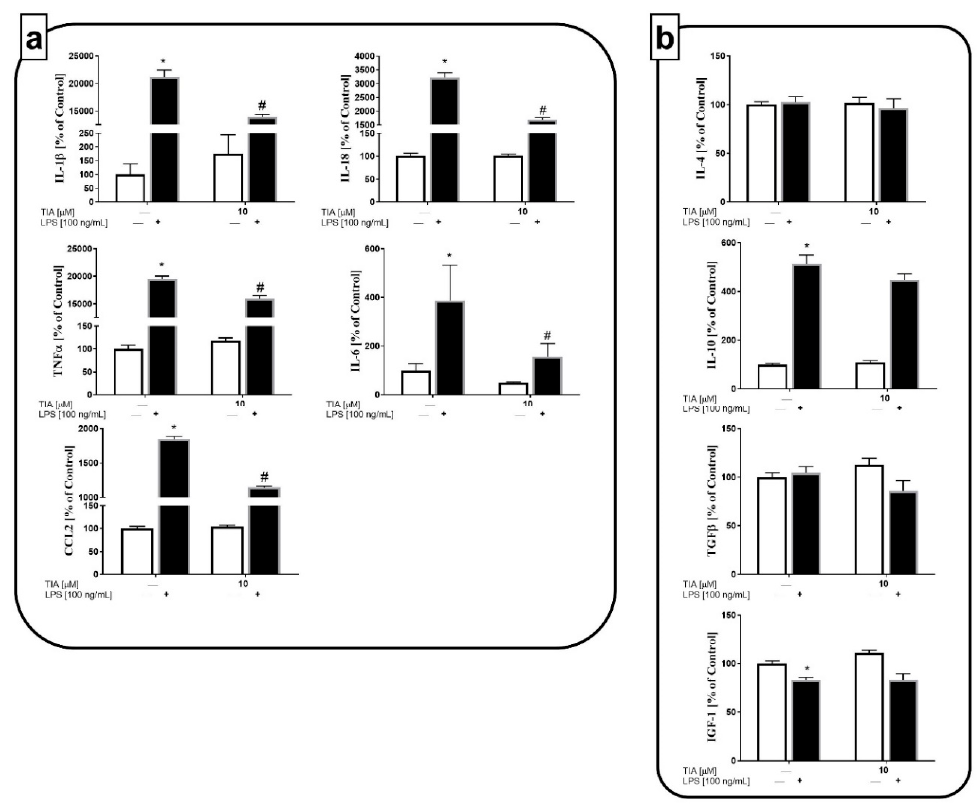
Figure 4. The effect of tianeptine (TIA) on the levels of pro-inflammatory (interleukin (IL)-1 β , IL-18, tumor necrosis factor alpha (TNF- α ), IL-6, and chemokine CC motif ligand 2 (CCL2)) ( a ) and anti-inflammatory (IL-4, IL-10, transforming growth factor (TGF- β ), and insulin-like growth factor 1 (IGF-1)) ( b ) factors in vehicle- and LPS-treated primary microglial cells. Microglial cells were pretreated